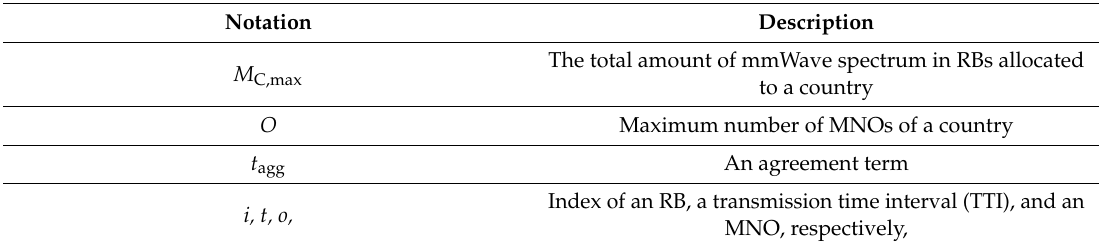
Table A1. A list of selected